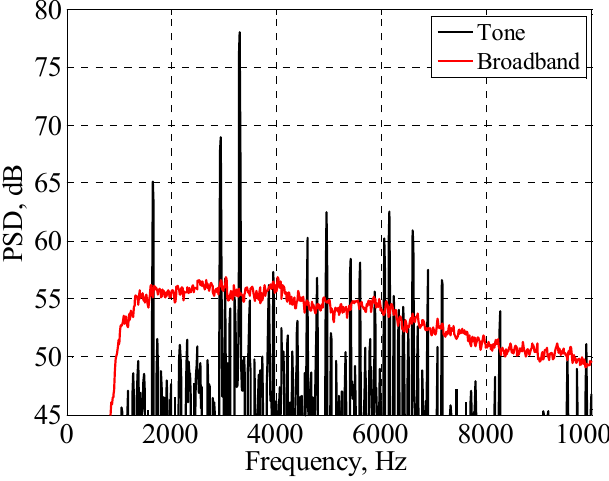
Figure 4. Tone and broadband noise spectra from a single-shaft fan calculated using the modified algorithm.